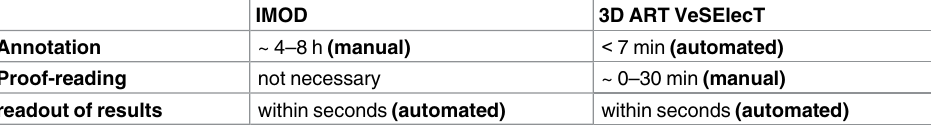
Table 1. Tabular schedule showing required time for semi-automated reconstruction.